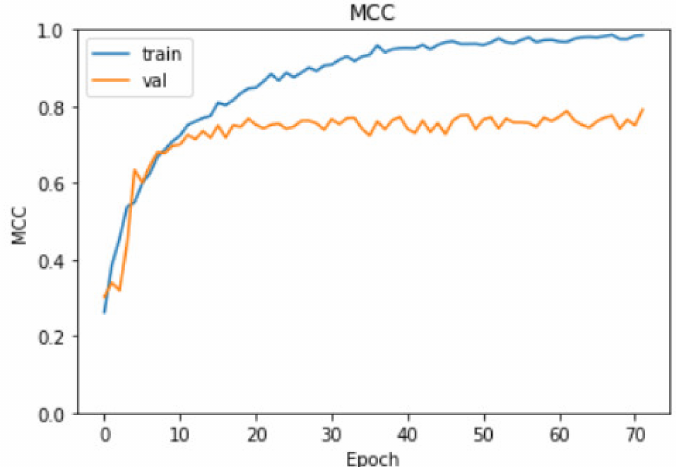
Figure 9. Matthews correlation coefficient curves.